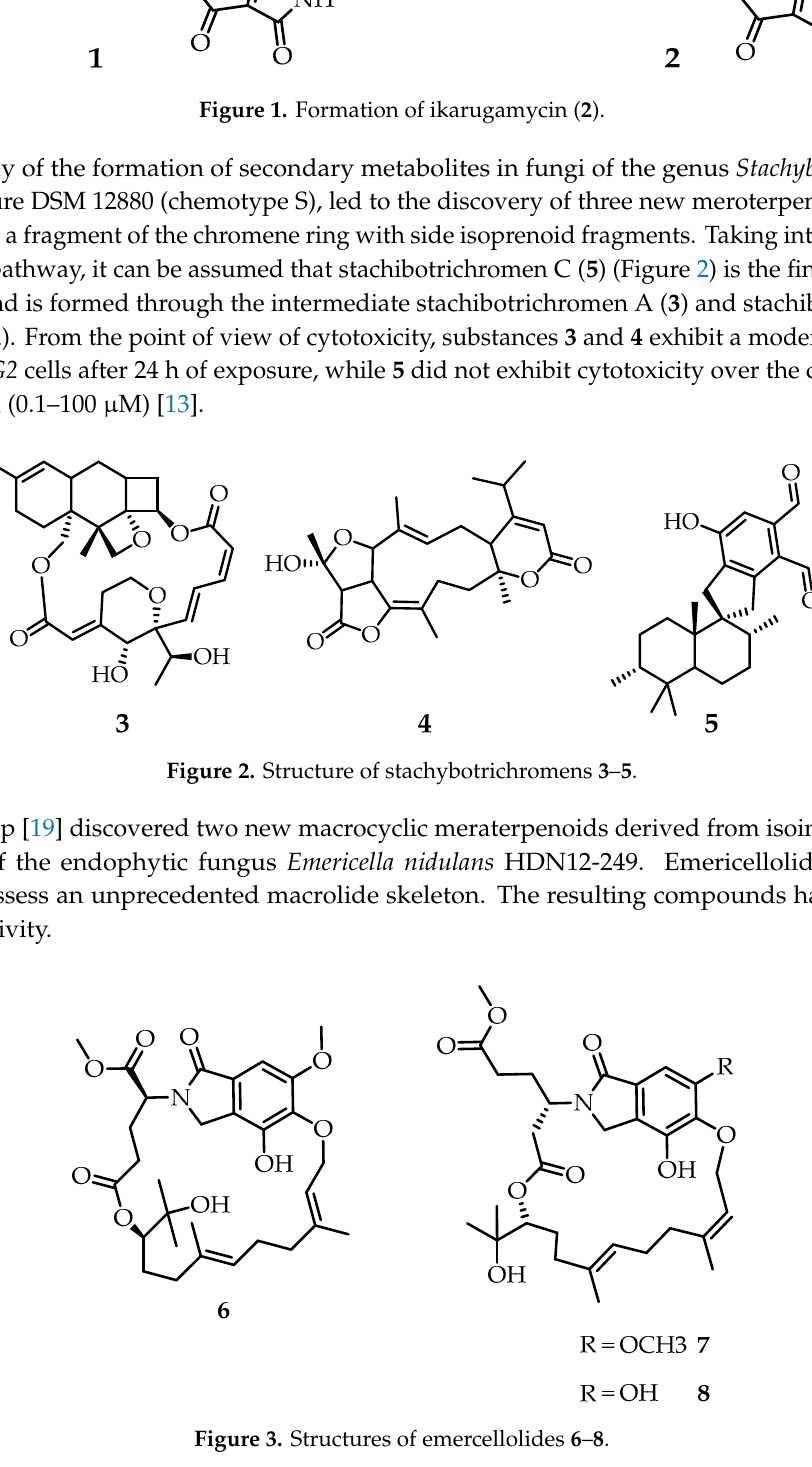
Figure 3. Structures of emercellolides 6 - 8 .